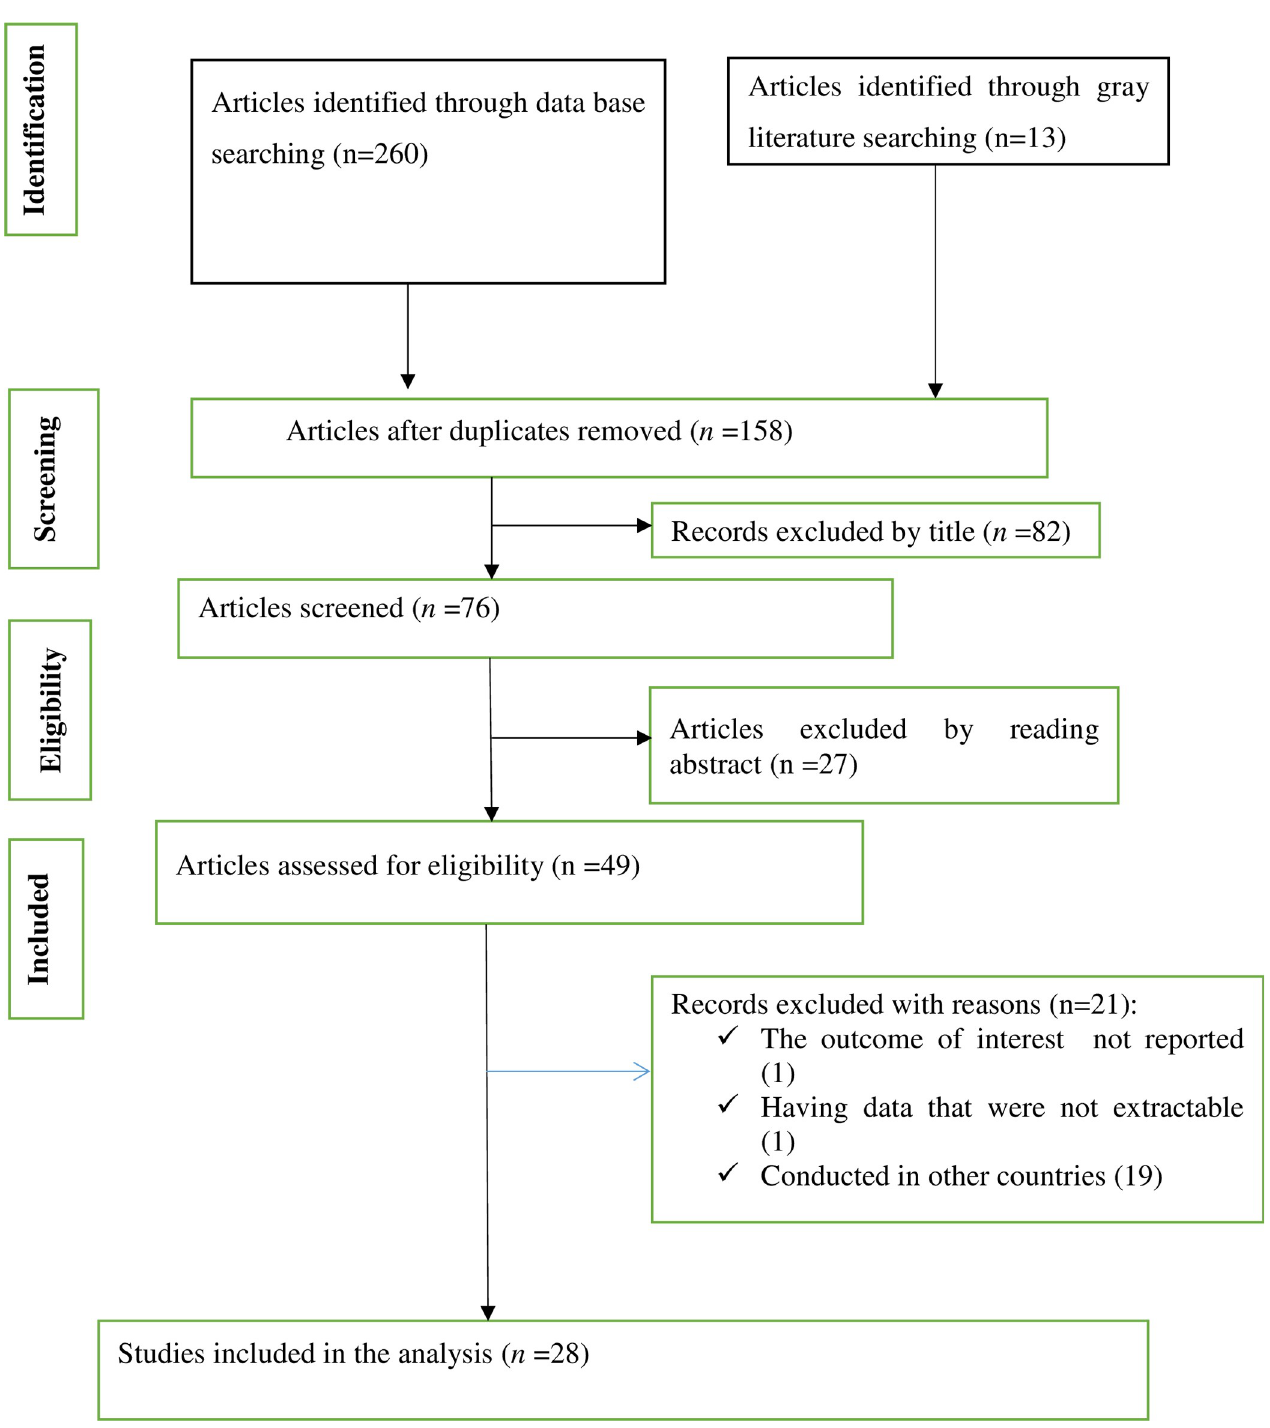
Fig 1. Flow chart diagram describing the selection of studies included in the systematic review and meta-analysis of prevalence and determinants of unintended pregnancy in Ethiopia.